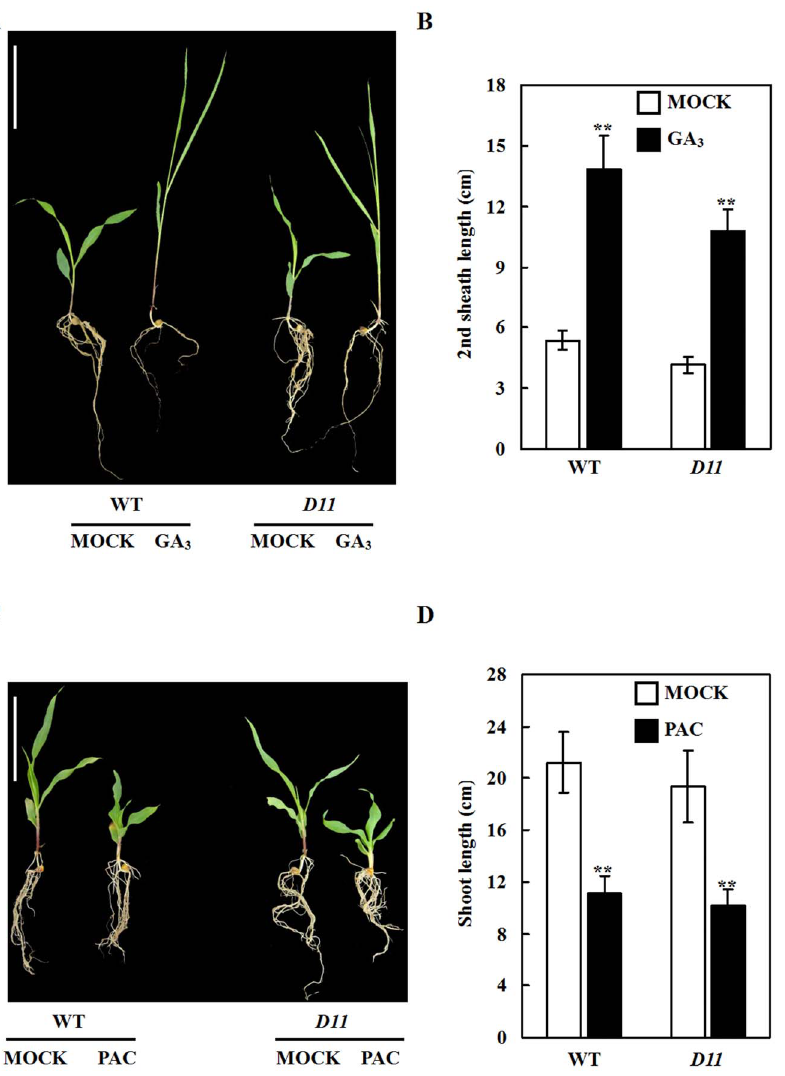
Figure 2. Response of maize D11 mutant to GA 3 and PAC application. ( A ) Seedlings of WT and D11 when treated with a 10 2 4 M GA 3 solution. Bar =10 cm. ( B ) The second leaf sheath length of WT and D11 ( n =35) when treated with a 10 2 4 M GA 3 solution. ( C ) Seedlings of WT and D11 when treated with a 10 2 4 M PAC solution. Bar =10 cm. ( D ) Shoot length of WT and D11 ( n =40) when treated with a 10 2 4 M PAC solution. In figures (B) and (D), data are mean 6 SD. Double asterisks indicate significant difference at P # 0.01 level compared with untreated samples by